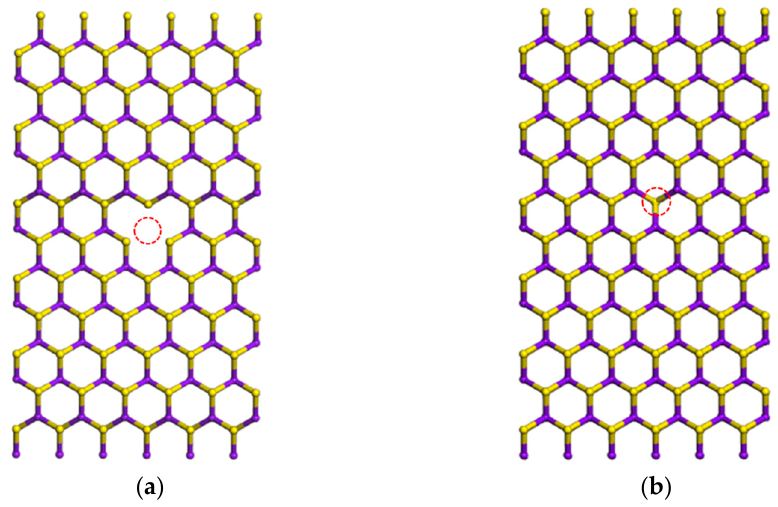
Figure 15. The atomic structure of MoS 2 SL unit cell: ( a ) with a Mo vacancy in the middle, ( b ) with a S vacancy in the middle. The red circle represents the Mo vacancy and S vacancy, respectively.